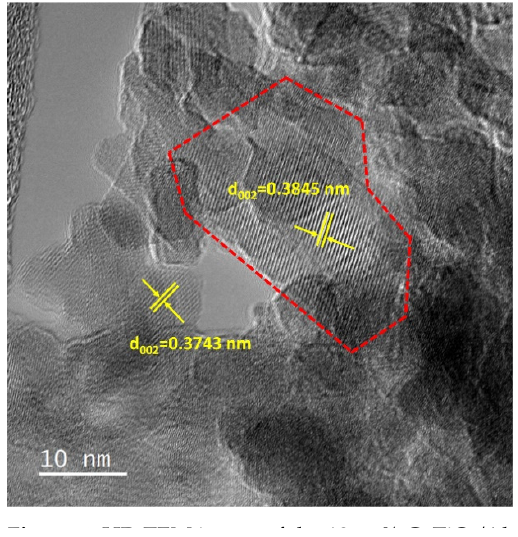
Figure 6. HR-TEM image of the 18 wt% CaTiO 3 /Al 2 O 3 sample